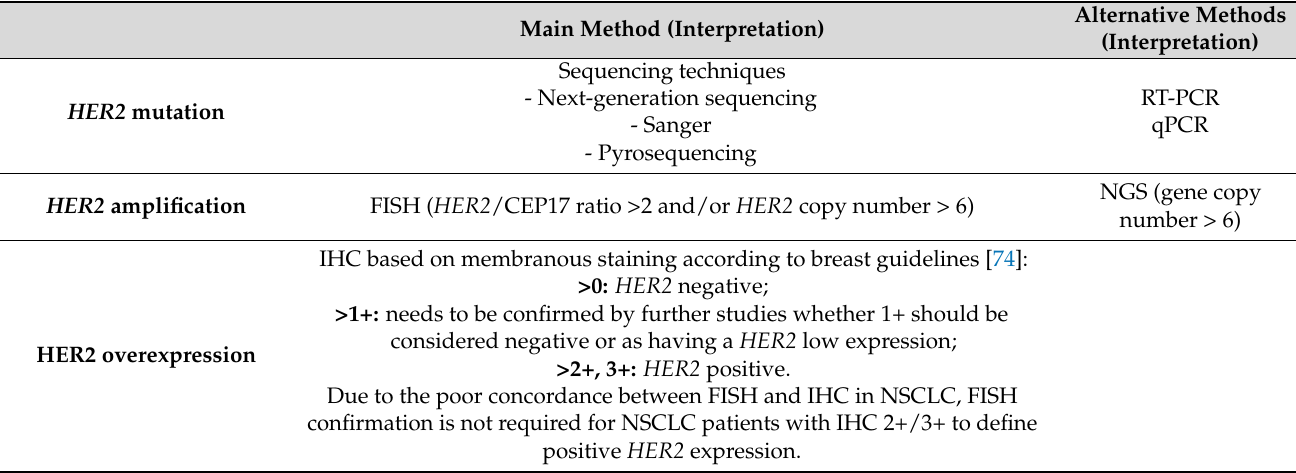
Alternative Methods (Interpretation)